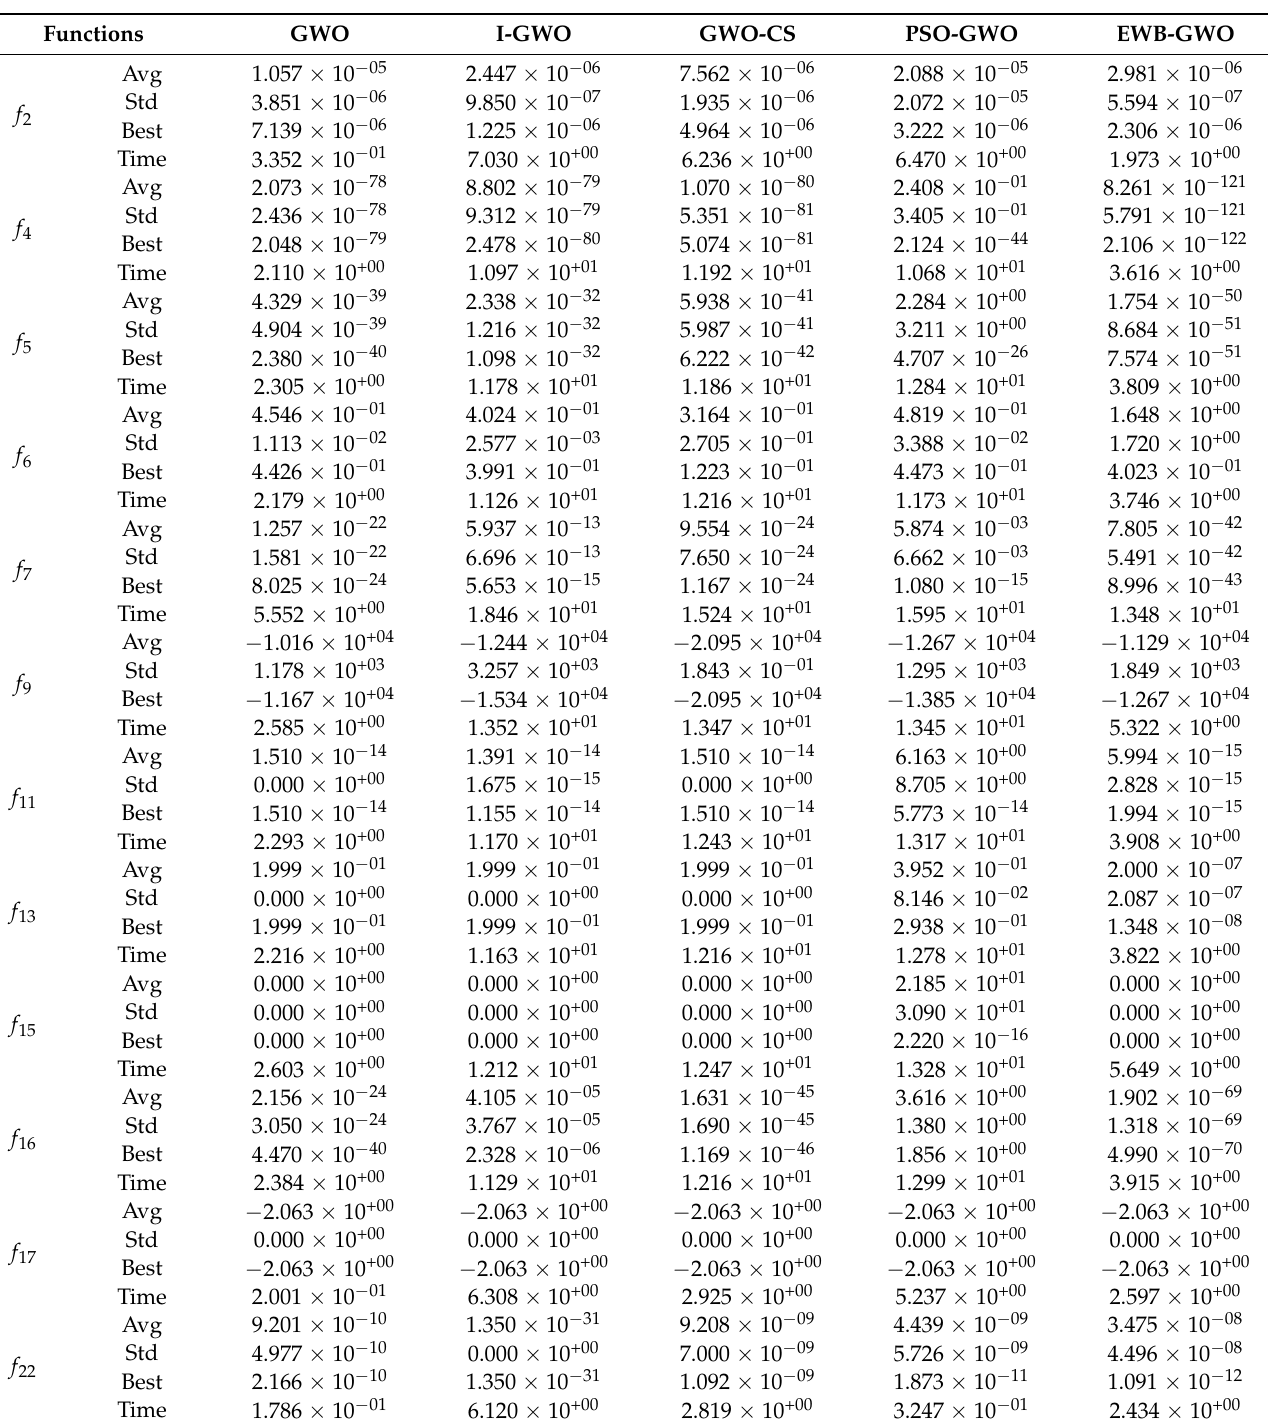
Table 5. Test results of the GWO-improved